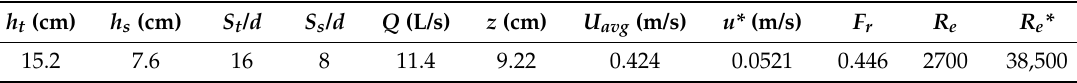
Table 1. Hydraulic conditions (Liu et al. [27]), where h t and h s are the taller and shorter vegetation heights, S t / d and S s / d are the larger (linear) and smaller (staggered) vegetation spacings, Q is the discharge, z is the water depth, U avg is the average velocity, u* = ( gzS ) 1/2 is the shear velocity, where g = 9.81 m/s 2 and S = slope, F r is the Froude number, R e is the cylinder Reynolds number, and R e * is the flow Reynolds